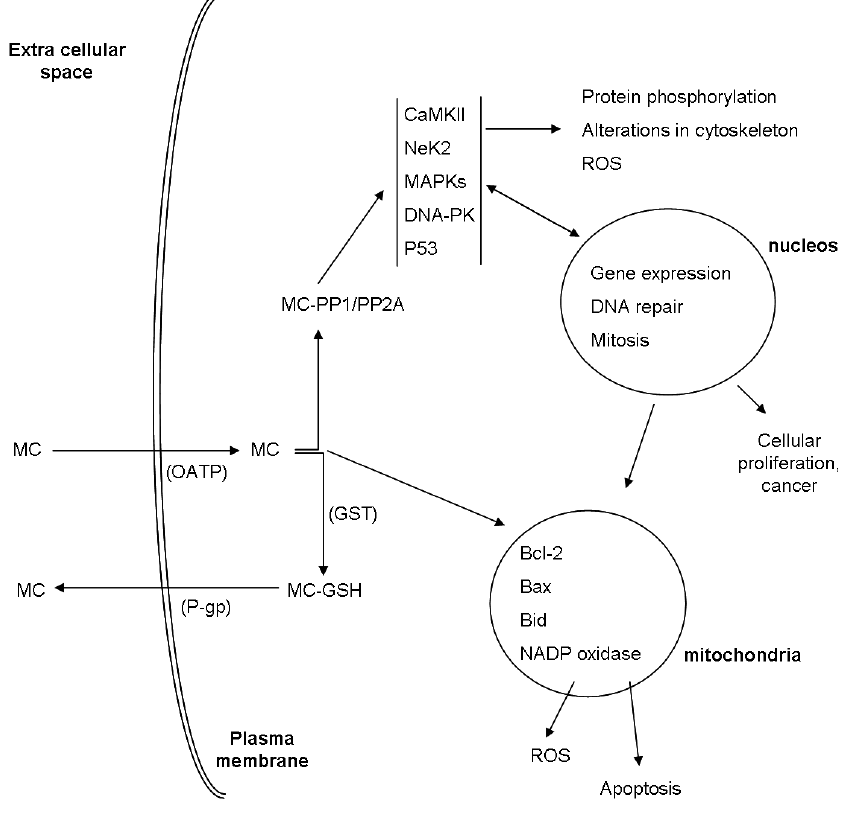
Figure 2. Suggested pathways of MC up-take, toxicity, biotransformation and excretion in animal